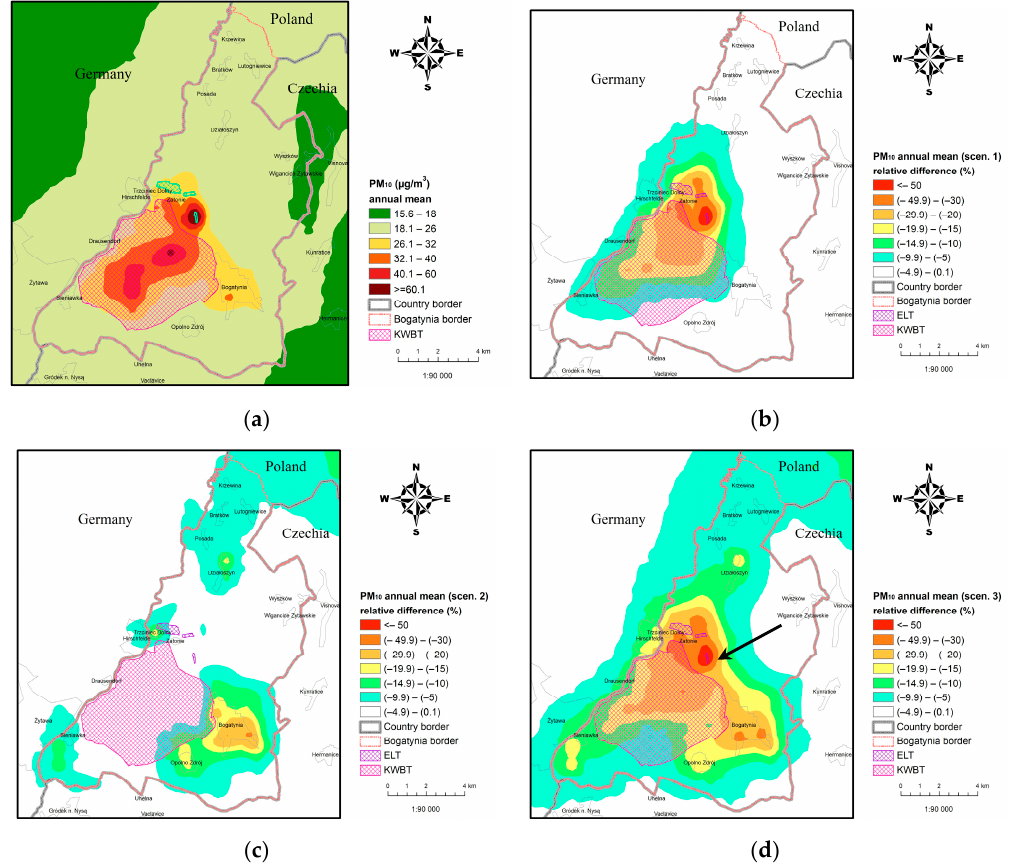
Figure 16. Annual mean PM 10 concentrations in 2018: modeled values and relative di ff erences for the analyzed scenarios (source: own study): ( a ) in 2018, ( b ) relative di ff erence for scenario 1, ( c ) relative di ff erence for scenario 2, ( d ) relative di ff erence for scenario 3.